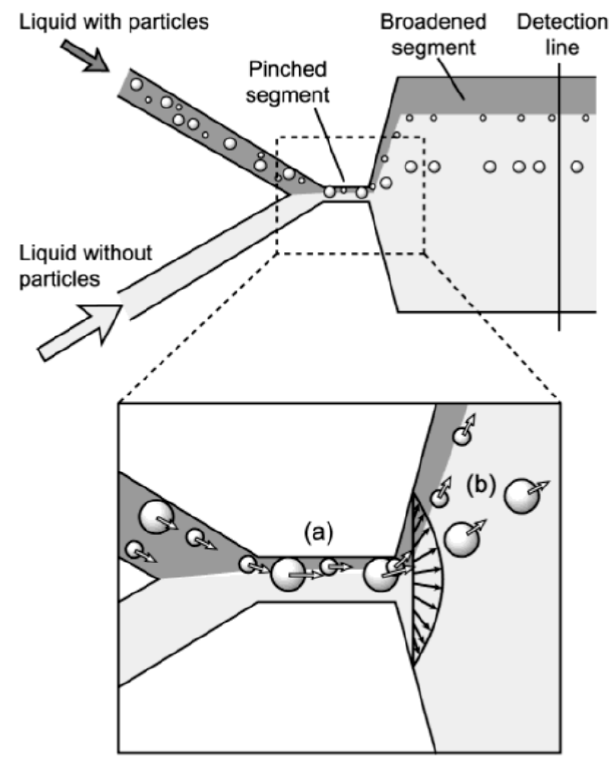
Figure 18. Principle of pinched flow fractionation. ( a ) In the pinched segment, particles are aligned to one sidewall regardless of their sizes by controlling the flow rates from two inlets; ( b ) particles are separated according to their sizes by the spreading flow profile at the boundary of the pinched and the broadened segments. The liquid containing particles is dark-colored. Reproduced with permission from [335]. Copyright 2004, American Chemical Society.